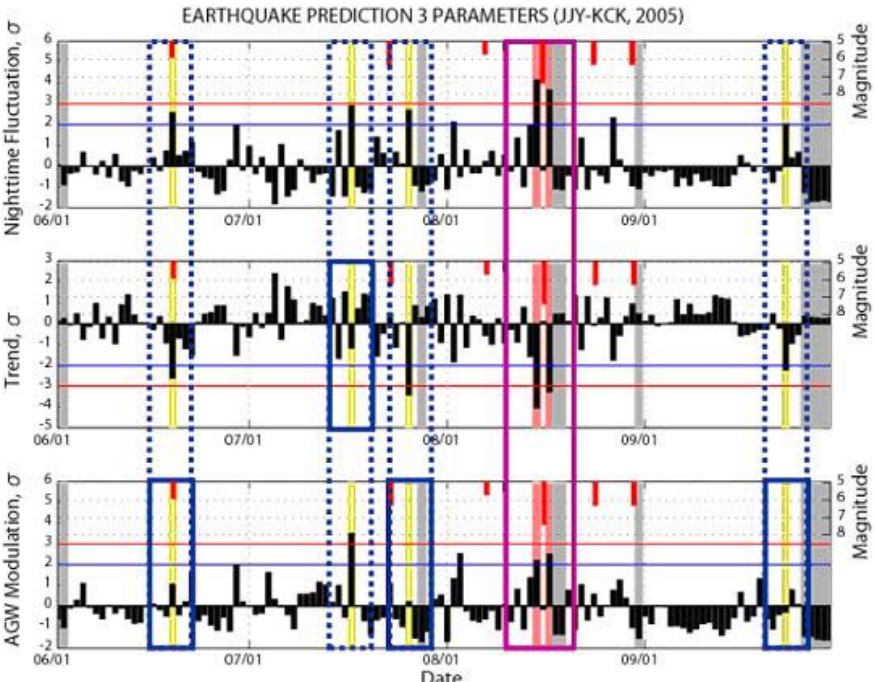
Fig. 4. Temporal evolutions of three physical parameters (nighttime fluctuation (NF), top; trend (nighttime average amplitude), middle; and AGW modulation index, bottom) during four months including the date of Miyagi-oki EQ on 16 August 2005 (Muto et al., 2009b). All of the three quantities are normalized by their corresponding standard deviations ( σ ) (during –30 to –1 day of the current day). The downward red bars in each panel indicate the times of EQs with length indicating the magnitude. In the red box you can find two red vertical bars and red means that all of three physical quantities satisfy their criteria, suggesting that these peaks are seismogenic as a precursor and an after-effect of the EQ. Gray zone means the period of no observation.